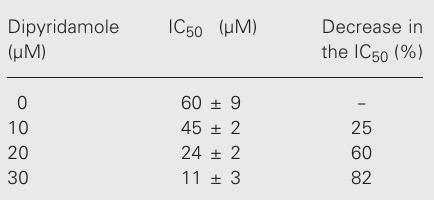
The cells were exposed to several cisplatin con- centrations (0, 20, 40, 80, 120 and 200 µM) with and without dipyridamole for 1 h at 37 º C (N = 5- 13). Data are reported as means ± SD. The IC 50 values for the association of the drugs were sta-